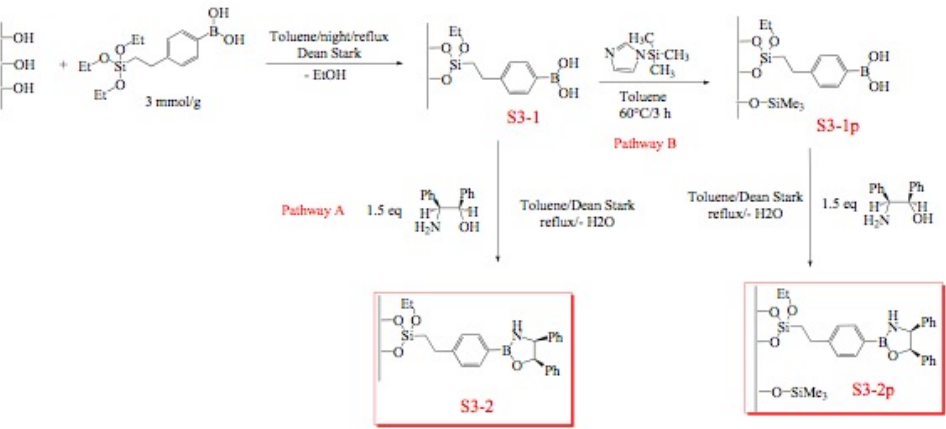
Figure 4. Direct immobilization of oxazaborolidine via boron